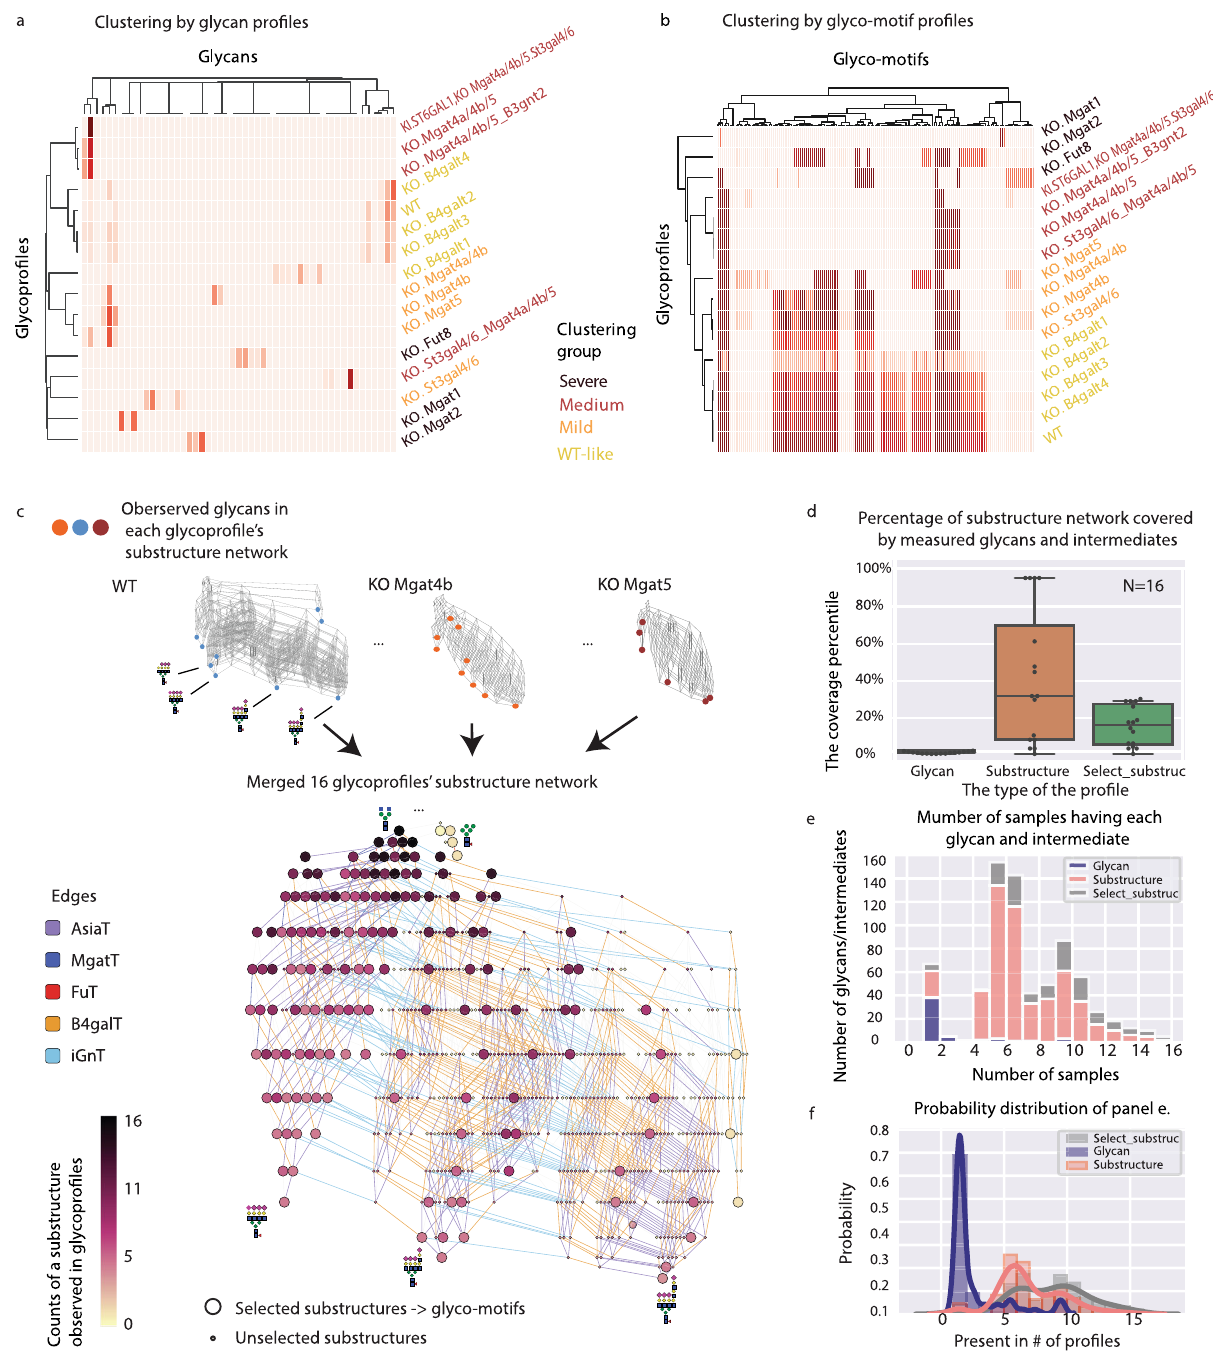
Fig. 3 Substructure-based pro fi le comparison solves the glycan non-independence and sparsity challenges, enabling the use of hierarchical clustering on large glycomics datasets. a Clustering of unprocessed glycopro fi les. Sixteen glycopro fi les from glycoengineered recombinant EPO were clustered based solely on their raw glycan abundances. b Clustering of glyco-motif pro fi les. The glyco-motif pro fi les, constructed using GlyCompare, were clustered based on the 151 glyco-motifs (see “ Methods ” ). There are four different phenotypic glycopro fi les (based on the glycoengineered glycosylation changes relative to wild type): WT-like (yellow), Mild (orange), Medium (red), and Severe (brown). The clusters of glycopro fi les and glycan substructures are de fi ned by distance threshold = 0.5. In both cases, hierarchical clustering was used with a complete linkage and correlation-distance using seaborn 0.9.0. c The pan-network (516 intermediate substructures) that describes the synthesis of all glycans measured on the 16 glycoengineered recombinant EPO N-glycopro fi les. The glyco-motifs (in larger size) are the minimal set of 151 substructures selected by GlyCompare for further multi-glycopro fi le comparison. The edges are colored by the enzyme family, AsiaT (purple), MgatT (blue), Fut (red), B4galT(orange), iGnt(cyan) and the node color according to frequency of existence in 16 glycopro fi les. d The coverage of the entire glycan synthetic pathway for 16 glycopro fi les using different structure types: glycan (purple, n = 16, Min = 0.00589, Q1 = 0.00786, median = 0.0128, Q3 = 0.0177, Max = 0.0236), substructure (gray, n = 16, Min = 0.005894, Q1 = 0.082515, median = 0.318271, Q3 = 0.698428, Max = 0.954813), and the selected-substructure (orange, n = 16, Min = 0.005894, Q1 = 0.058448, median = 0.161100, Q3 = 0.276031, Max = 0.290766). e Proportion of samples containing a glycan, substructure, or glyco-motif in the 16 samples, and f the associated probability distribution. Source data are provided as a Source data fi le. NATURE COMMUNICATIONS| (2021) 12:4988 |https://doi.org/10.1038/s41467-021-25183-5|www.nature.com/naturecommunications